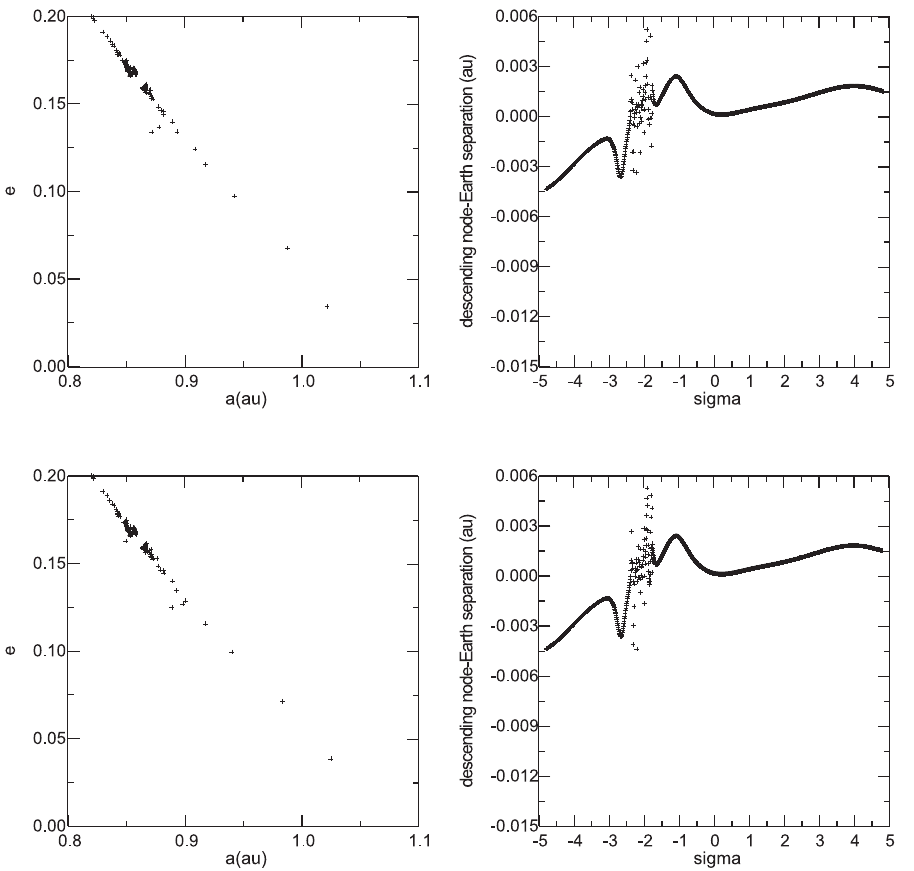
Figure 5. The LOV 2 method. Left panels - phase space of ( a , e ) on MJD122774.0 (JD2522774.5 = 2195-Jan-8). Right panels - distance of ascending node of VAs of asteroid 2001 BB16 relative to the sigma parameter, at that same time as in the left panel, i.e. on MJD122774.0 (JD2522774.5 = 2195-Jan-8). σ max =5 and ∆σ max =0.01. IP = 2· 10 −6 which gives 963 multiple solutions for top panels and IP = 2· 10 −7 with ∆ 2599 multiple solutions for bottom panels. Compare with Figure 3 resulting from the LOV 1 method.